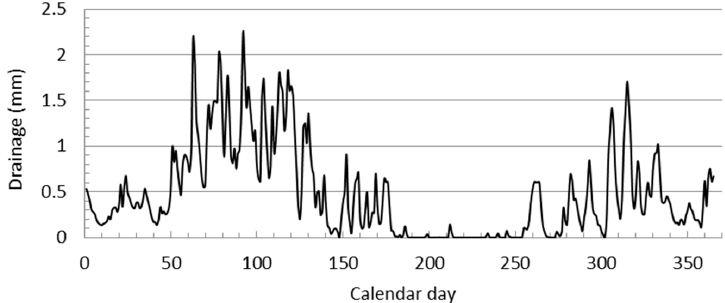
Figure 4. Predicted drainage flow in mm over the watershed per day over the model simulation period.